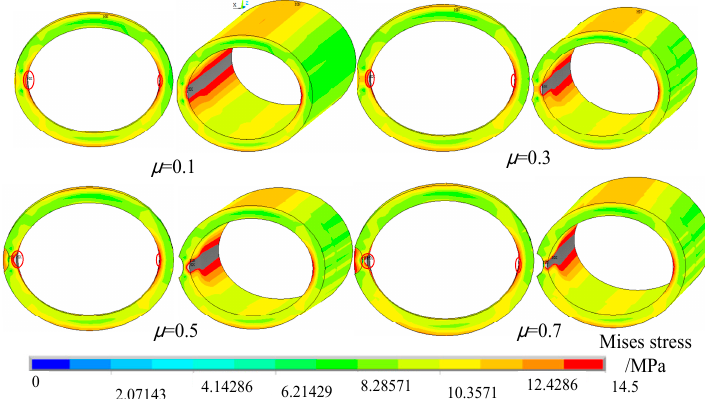
Figure 17. Location of HDPE pipeline failures with various defect depths.